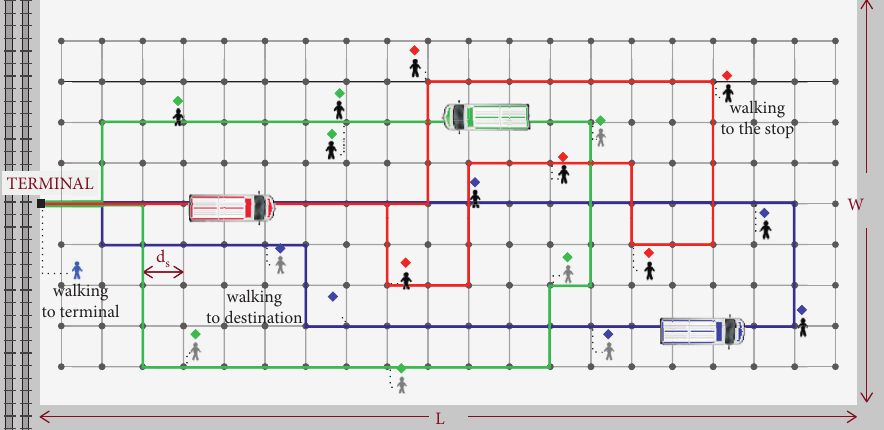
Figure 3: Scheme of the DRF service: users in black are waiting for the assigned vehicle, users in grey have left the vehicle and are walking to their destination, and the user in blue is walking directly to the